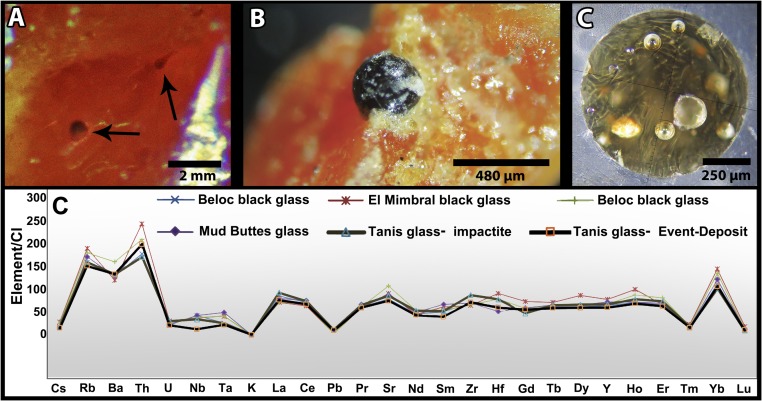
Chicxulub impact glass from Tanis, and geochemical comparison. (A) Magnified view of spherules within amber (FAU.DGS.ND.161.77.T). (B) Exposed unaltered spherule, in situ within amber (FAU.DGS.ND.161.735.T). (C) Thin section of unaltered glassy spherule recovered from amber (FAU.DGS.ND.161.997.T). (D) CI-normalized geochemistry highlighting the strong match between the ranges for Chicxulub black glass and the Tanis specimens.